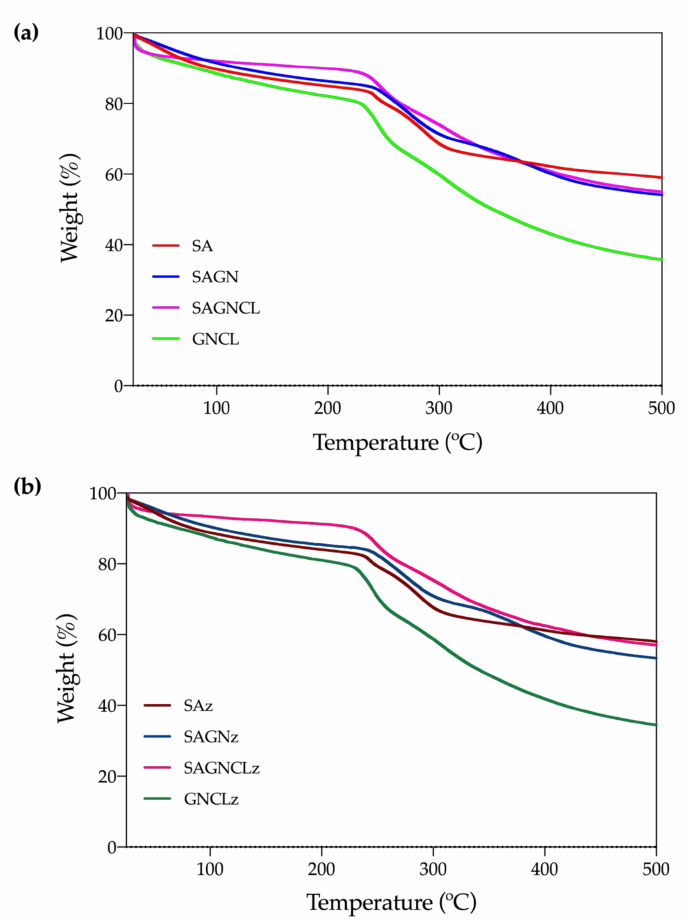
Figure 4. Thermogravimetric Analysis (TGA) curves of ( a ) SA, SAGN, SAGNCL, GNCL and ( b ) SAz, SAGNz, SAGNCLz and GNCLz microfibers, obtained from 25 to 500 ◦ C under nitrogen atmosphere at flow rate of 200 mL/min and temperature rise of 10 ◦